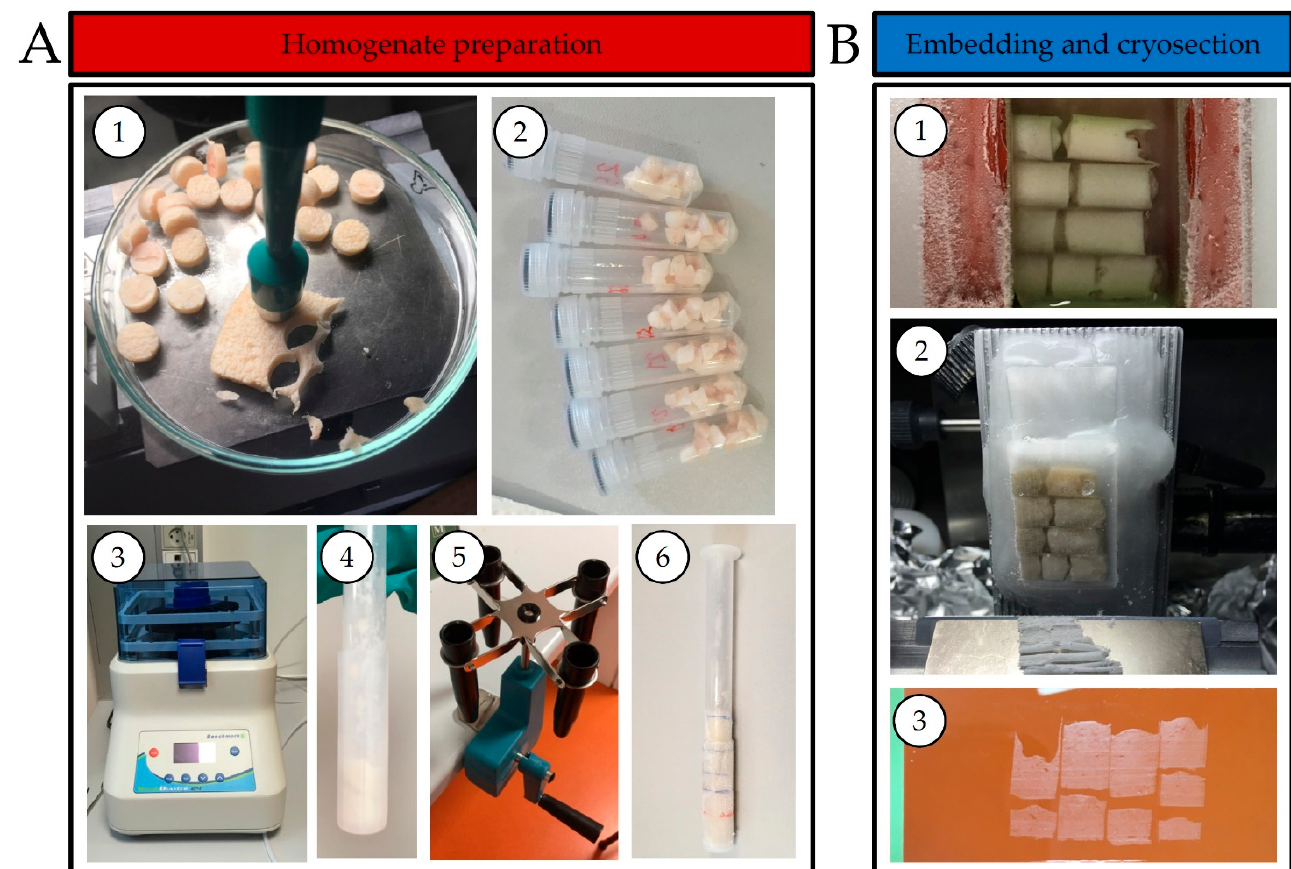
Figure 1. Mimetic tissue model preparation. ( A ) Homogenate preparation: punching of 8 mm biop- sies (1), cutting in smaller pieces for a homogenization tube with water and 2 steel homogenization beads (2), homogenization (3), deposition of homogenate into a dosing pipette (4), centrifugation (5) and the frozen dosing pipette with homogenate (6). ( B ) Embedding and cryo-sectioning of the homogenate: embedding of the homogenates in a 5% CMC gel (1), cryo-sectioning of mimetic tissue model (2) and final section of the mimetic tissue model (3).